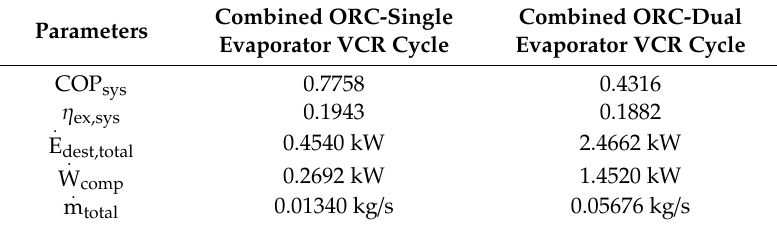
Table 8. Comparison of proposed